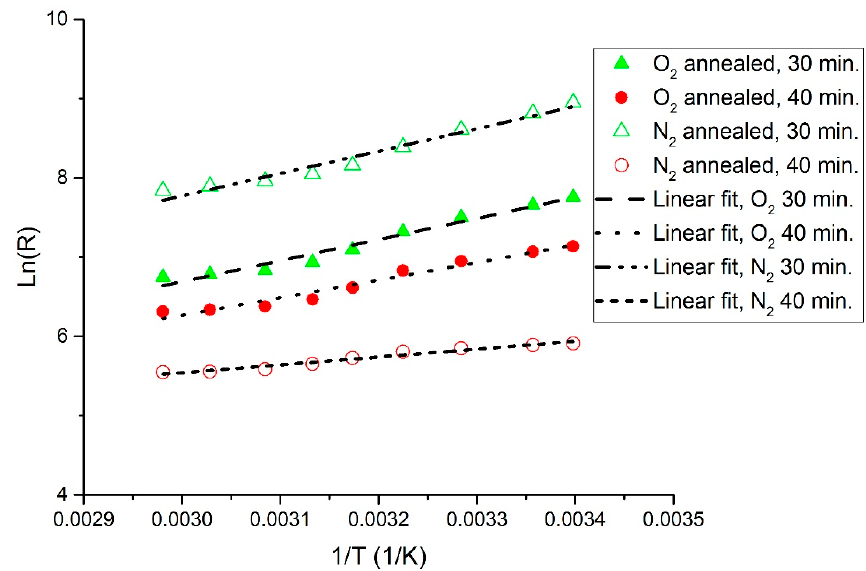
Figure 6. Ln( R ) versus 1/ T Arrhenius plot for O 2 - and N 2 -annealed resistive thermometers.